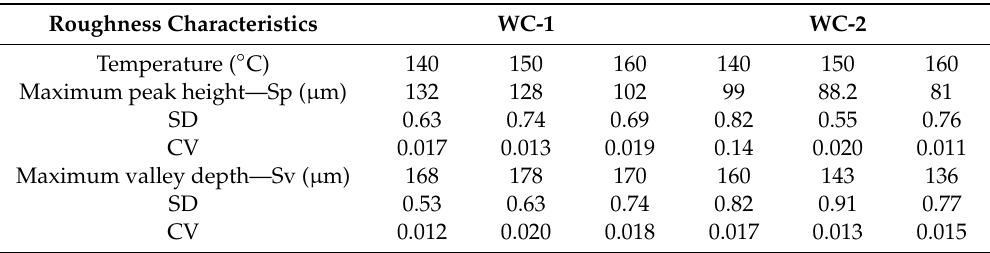
Table 7. Roughness characteristics for WC-1 and WC-2.